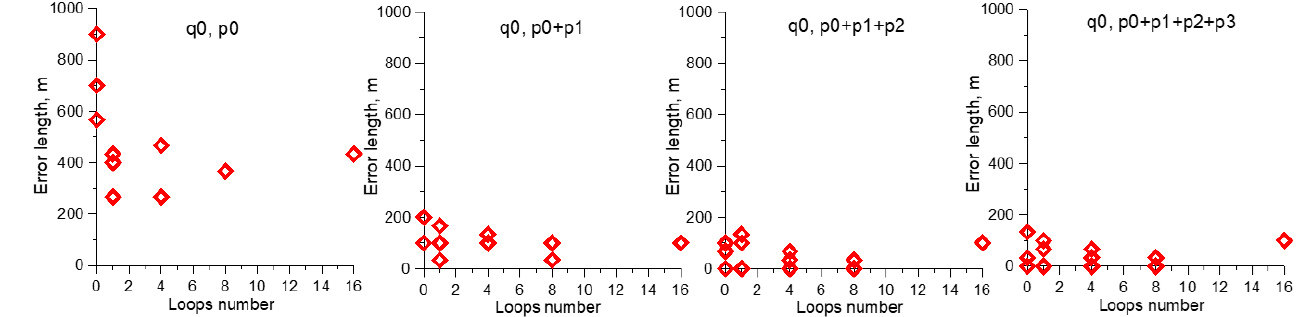
Figure 11. The average length of the error in relation to the total pipe length and the number of monitoring sensors applied.